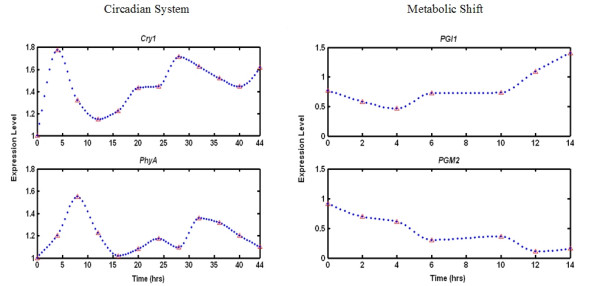
The expression profiles derived from the cubic spline interpolations. The expression profiles after performing the cubic spline interpolations for Cry1, PhyA (pathway of circadian regulatory system of Arabidopsis thaliana) on the left-hand side, and PGI1, PGM2 (metabolic shift pathway of yeast Saccharomyces cerevisiae) on the right-hand side. The red open triangles are the raw microarray data, and the blue dotted points are the interpolation data.